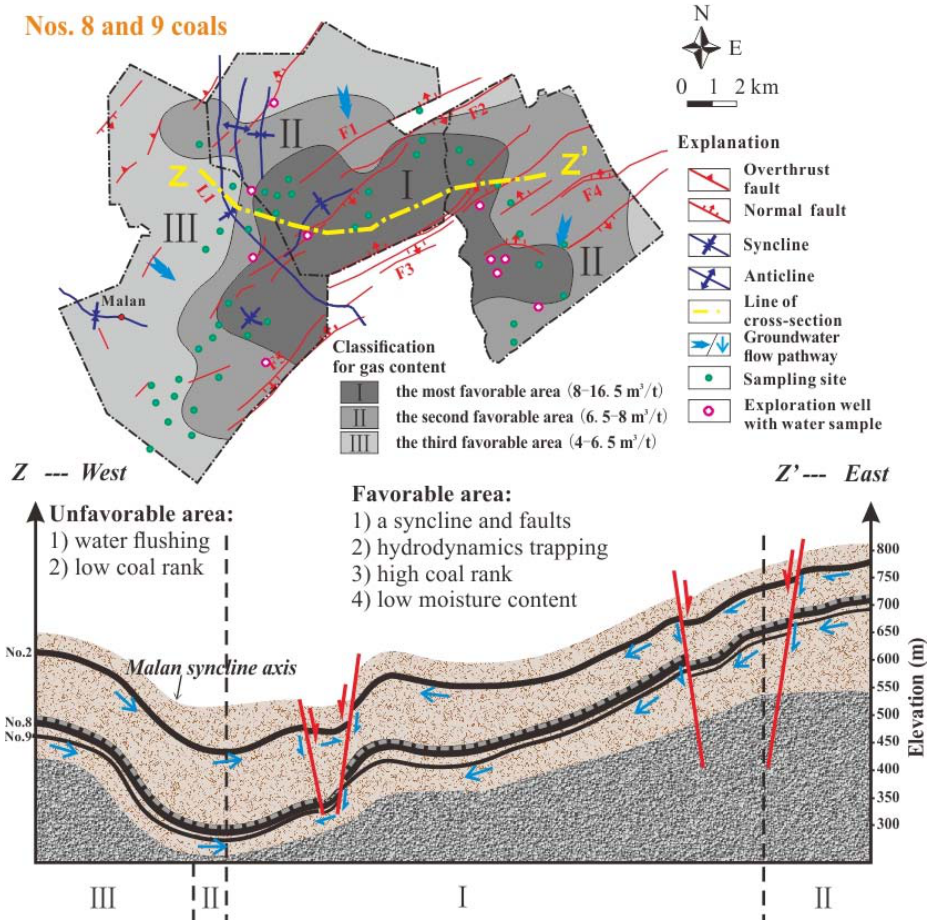
Figure 14. Evaluation for gas content in the Nos. 8 and 9 coals classified into Areas I, II, and III associated with stratigraphic profile Z–Z’, blue arrows is the flow direction.